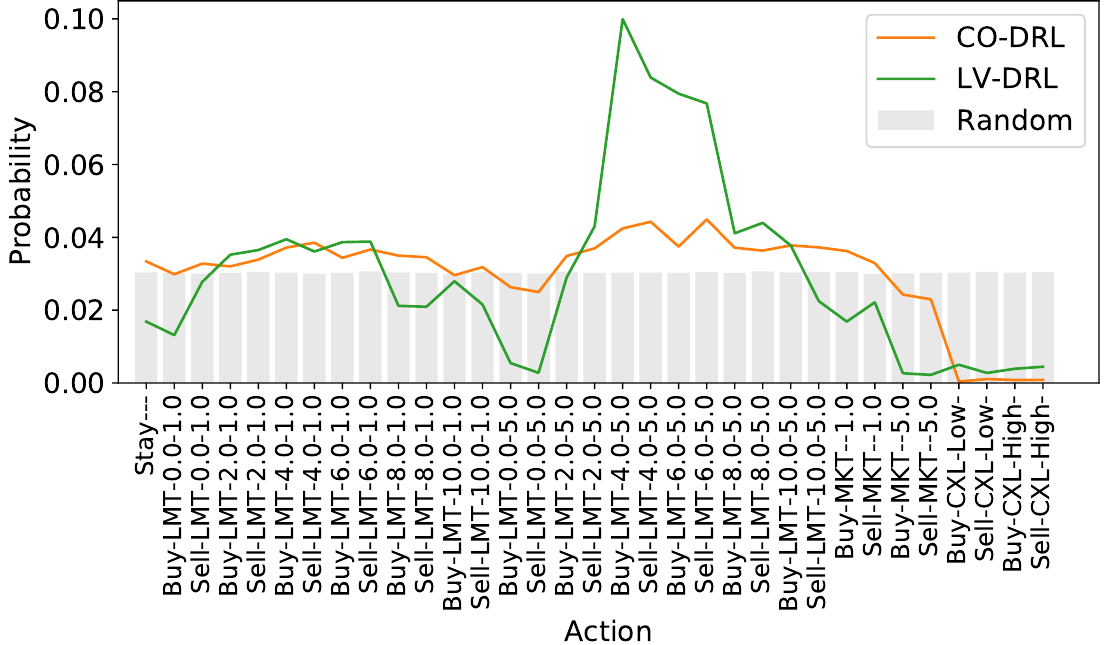
Figure 6. Action probabilities of three models in validation. The horizontal axis represents possible actions which are expressed by “Action-Order type-Price(difference from the price of market order in limit (LMT) and market (MKT) orders, lowest or highest in cancel (CXL)